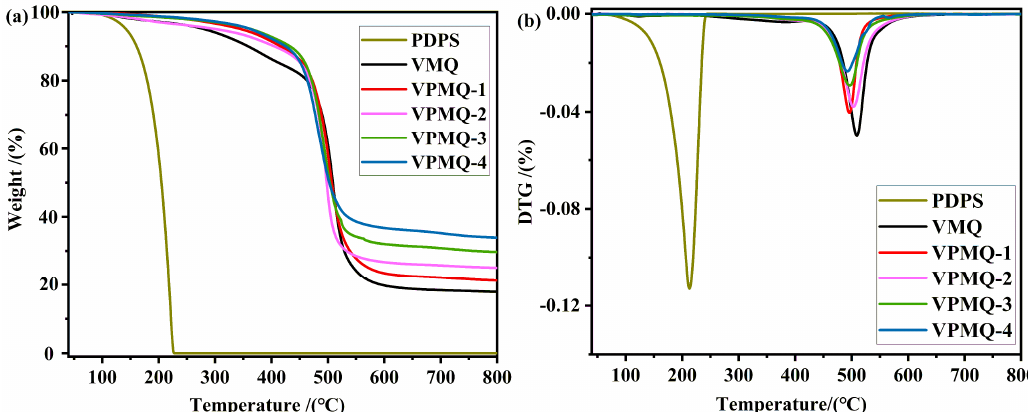
Figure 6. TG curves ( a ) and DTG ( b ) curves for VMQ and VPMQ series obtained under a nitrogen atmosphere. Table 3. The characteristic degradative data of VMQ and VPMQ